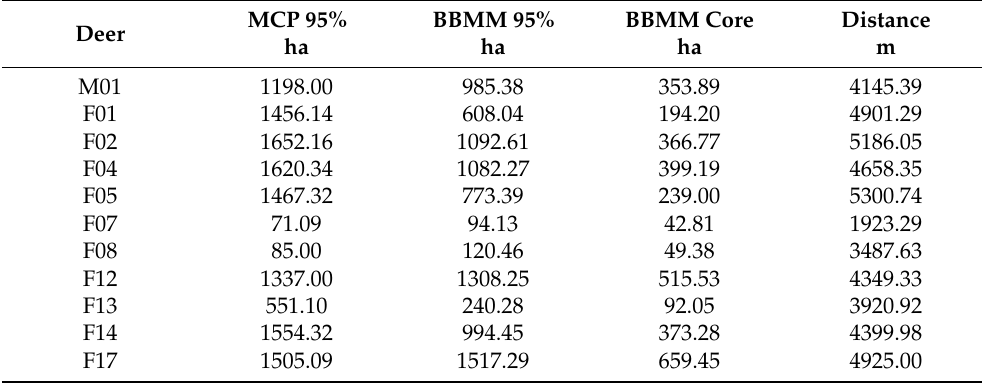
Table 2. Estimated total home range and maximum distance from release site for 32 GPS-tracked Corsican red